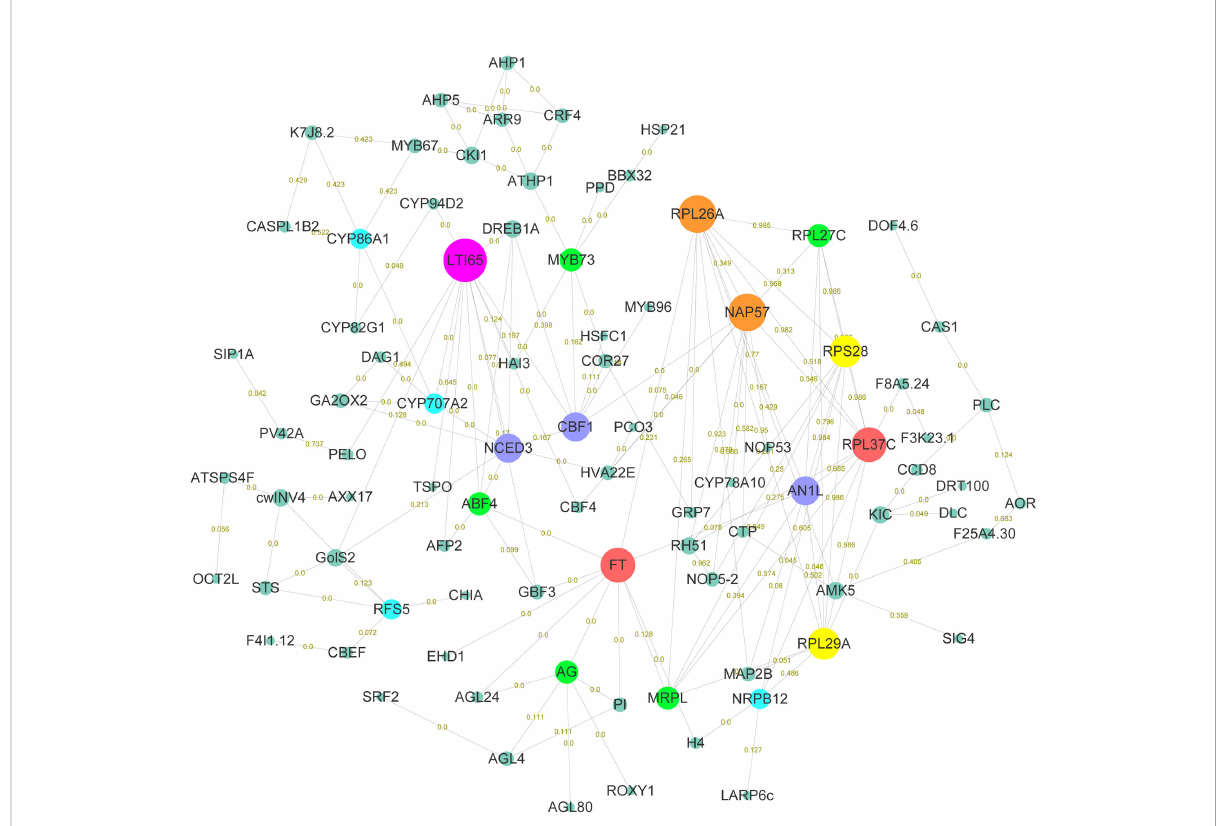
FIGURE 4 Functional enrichment analysis of early fl owering-related genes and protein-protein interaction networks. Proteins are named based on the orthologous sequence of A. thaliana . The size of the circle represents the combined score of the STRING database rating. The connectedness is distinguished by different colors. The numbers on the connecting lines represent the coexpression of